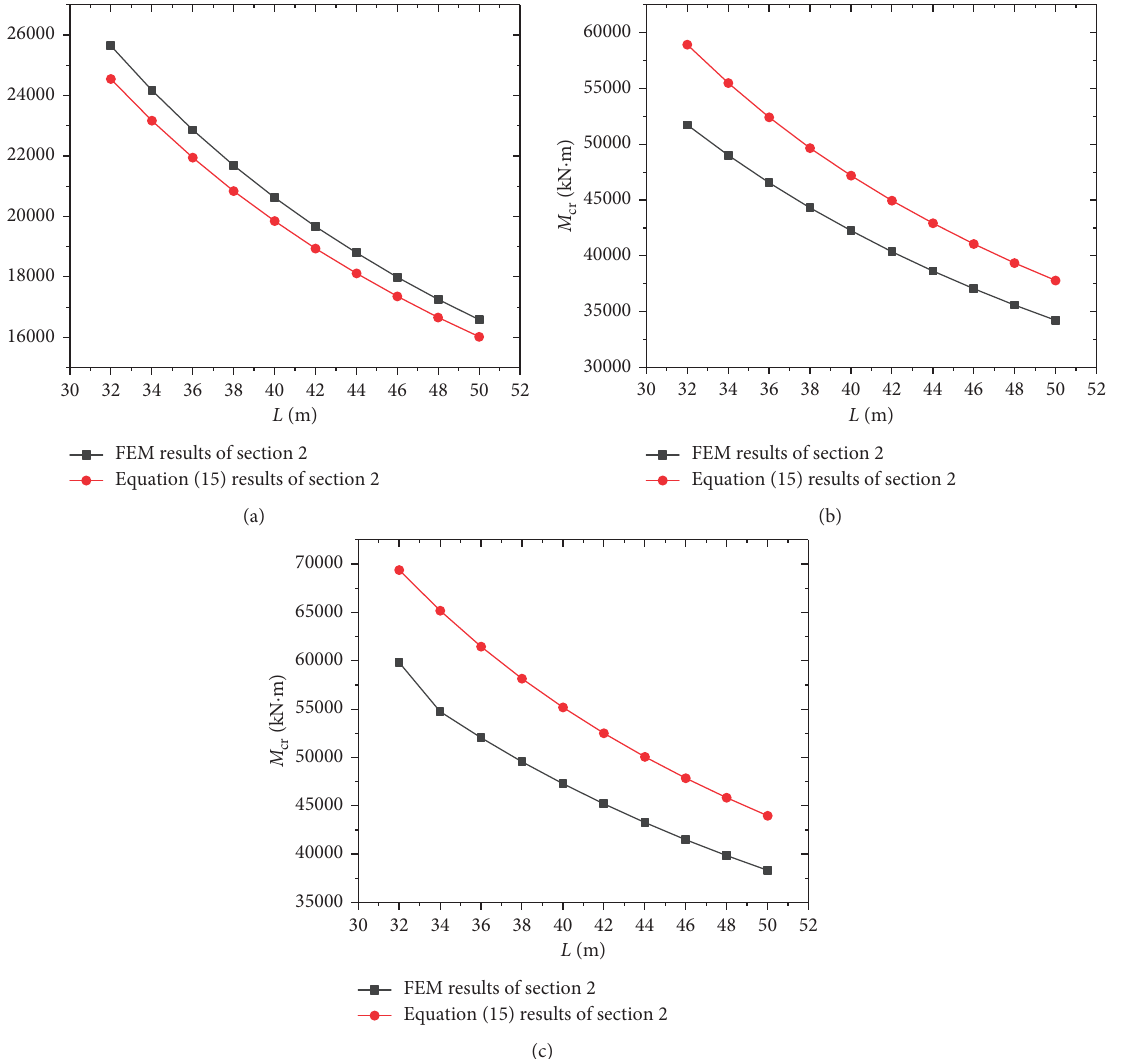
Figure 12: Relationship between critical moments and span (section 2). (a) 􏽥 R � 0, (b) 􏽥 R � ( 1/2 ) 􏽥 R